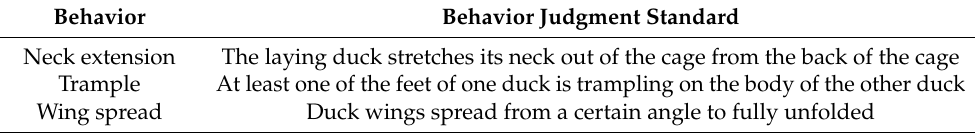
Table 1. Judgment standards of cage-reared duck behaviors.